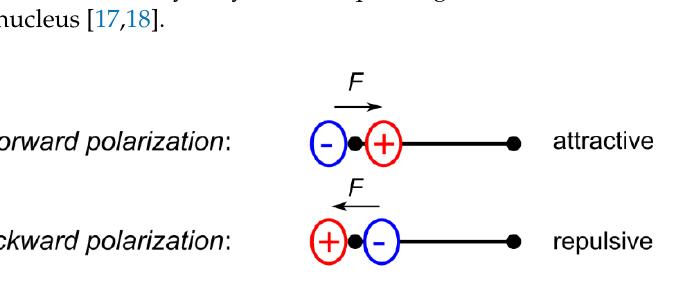
Figure 1. Two cases of dipolar core-polarization of first-row atoms. Dipolar core polarization also leads to a shift of the atomic position at the HCM level.